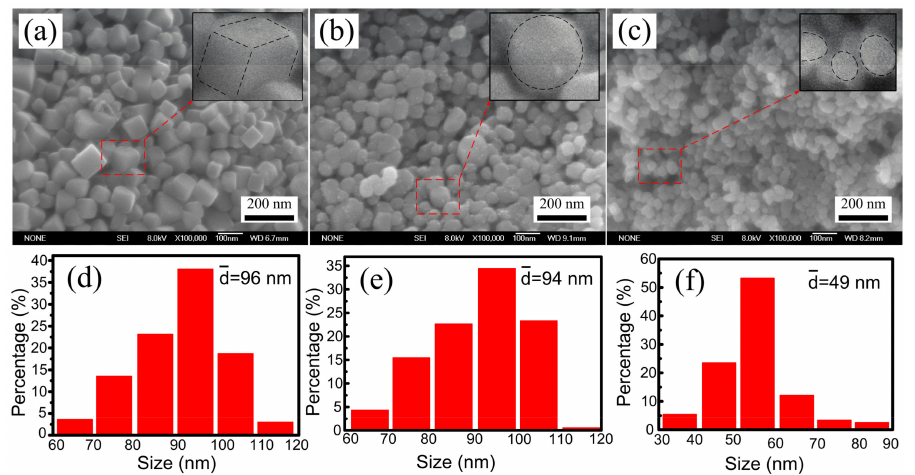
Figure 3. ( a – c ) Field emission SEM (FESEM) images and ( d – f ) corresponding size distribution of the TiC x particles extracted from composites 1, 2, and 3.